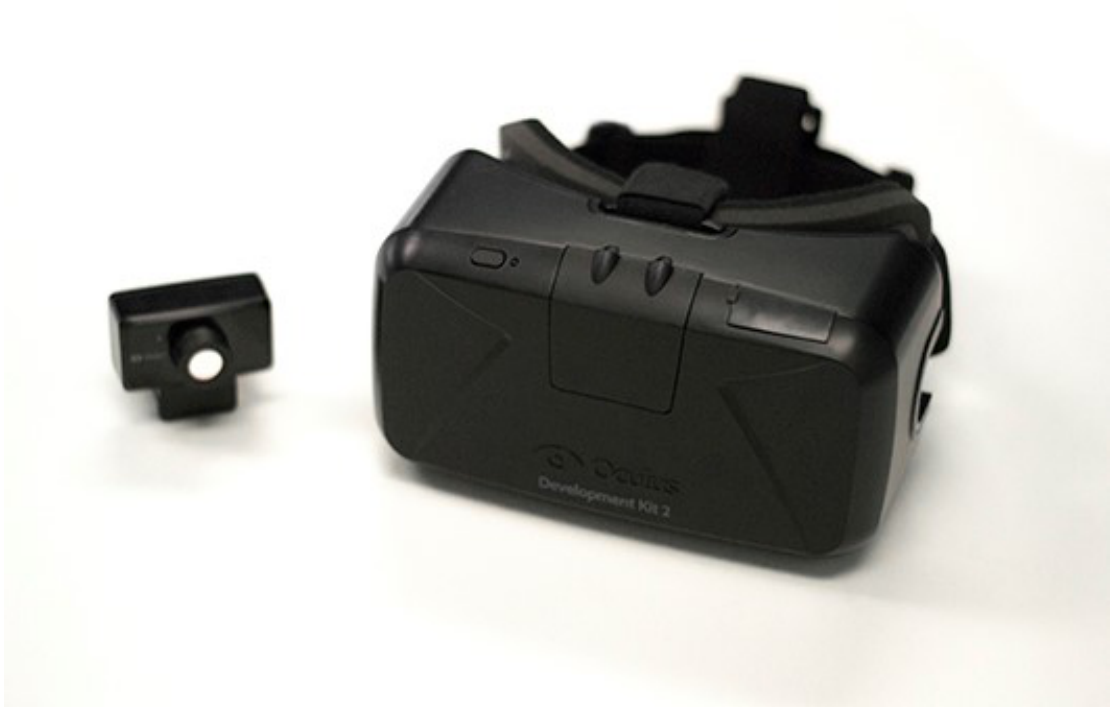
Figure 1. Oculus Rift version DK2 with movement capture camera. Source: